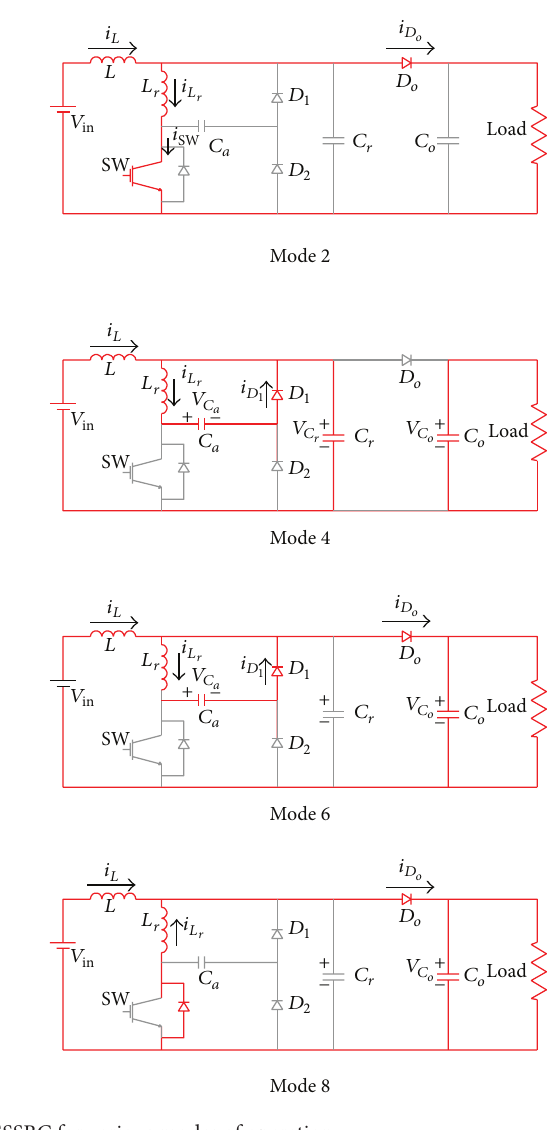
Figure 4: Equivalent circuit diagram of SSSSBC for various modes of